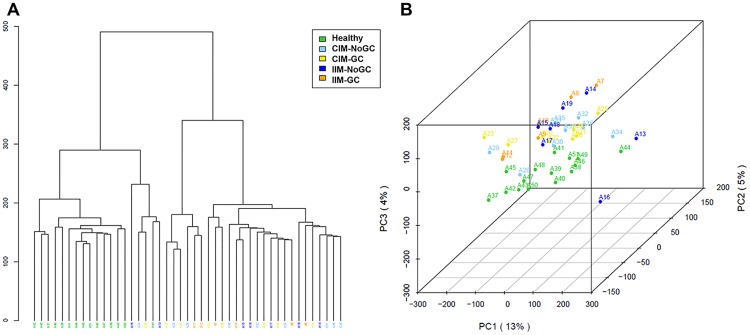
Dendrogram and principal component analysis of the analysed samples.A) Dendrogram showing the hierarchical clustering of the analysed samples. Clustering was based on the overall gene expression values of the studied groups. B) Principal Components Analysis.